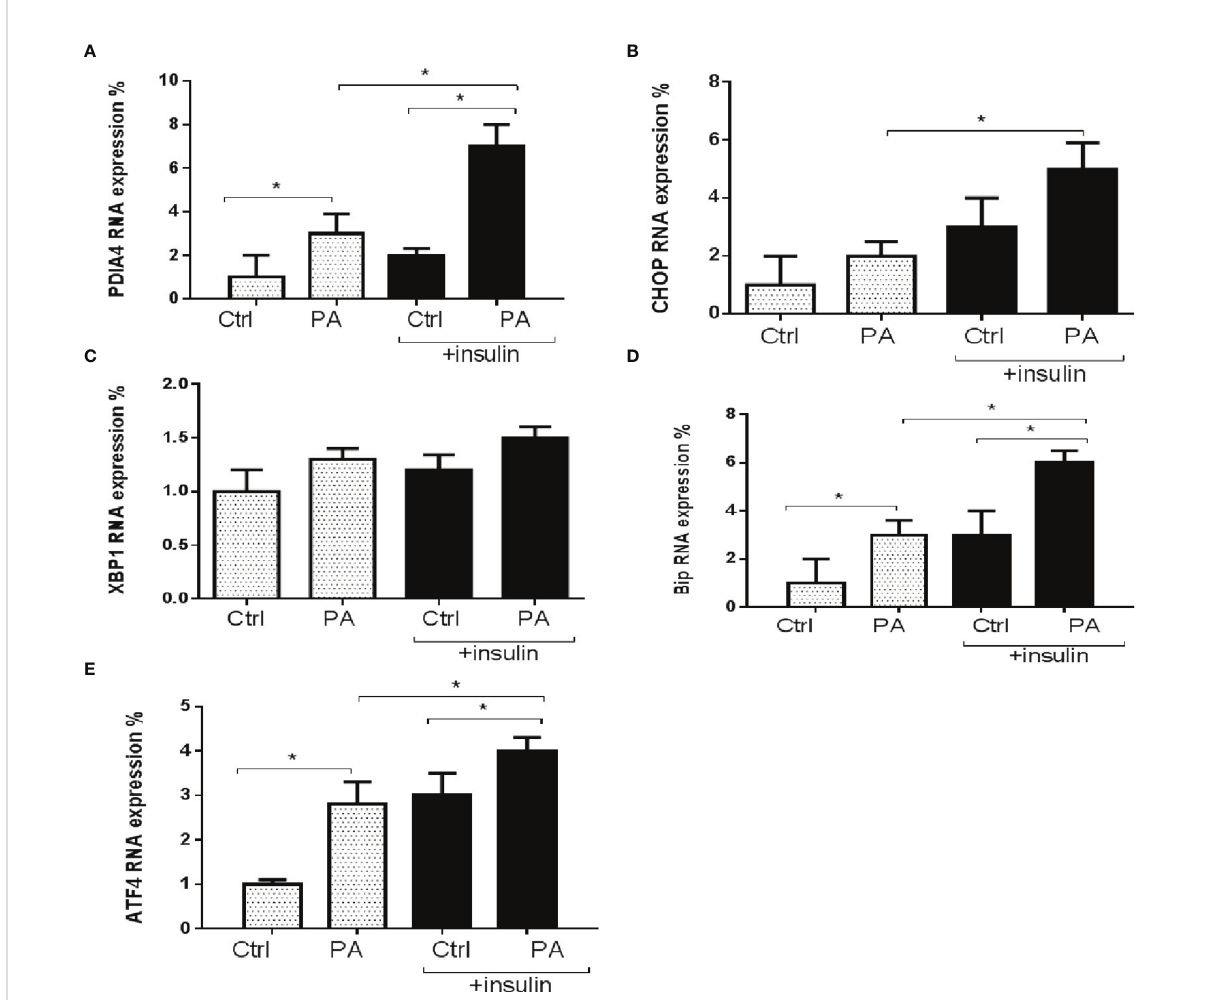
FIGURE 2 Palmitate increased PDIA4 and other ER stress markers in C2C12 cells. The levels of (A) PDIA4, (B) CHOP, (C) XBP1, (D) Bip, and (E) ATF4 mRNA were analyzed by real-time PCR after C2C12 myotubes treated with 0.6 mM of palmitate (PA) with or without 100 nM insulin. All data are presented as the mean ± SD (n = 3 for each group); *P <